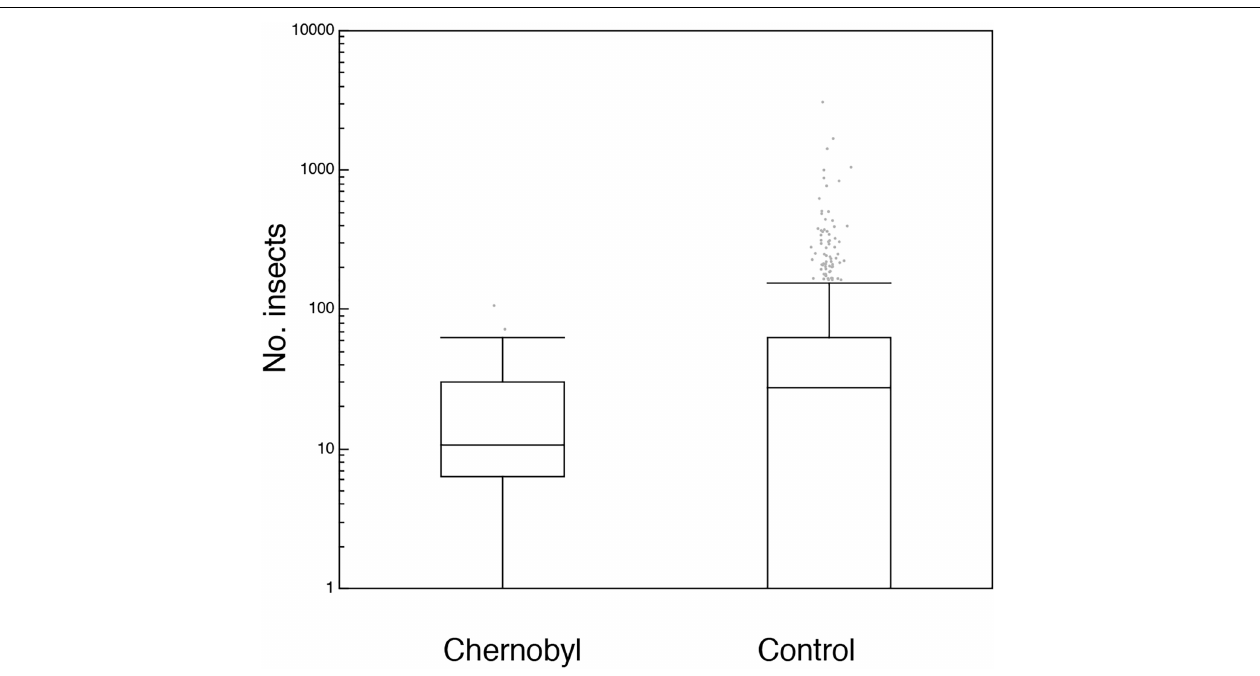
FIGURE 1 | Box plots of the number of insect sampled with a car in Chernobyl and in uncontaminated control areas in Europe. The box plots show median, quartiles, 5- and 95-percentiles and extreme values. Observations are jittered to make all observations